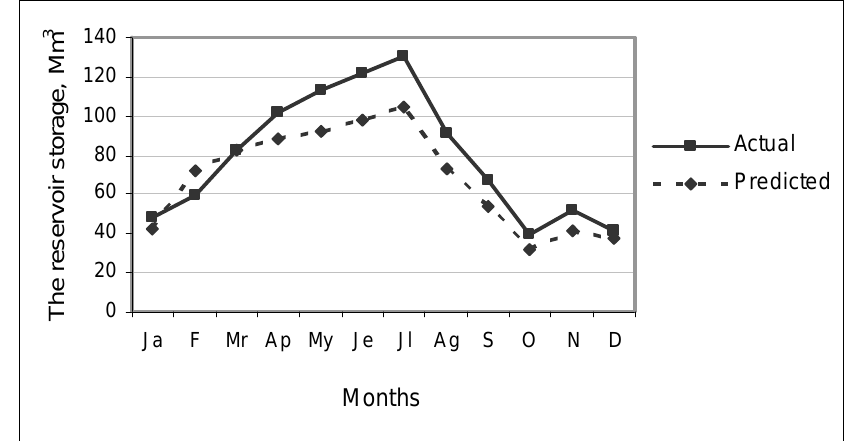
Figure 4. Comparison of predicted and actual values of water storage in the Papan Reservoir,